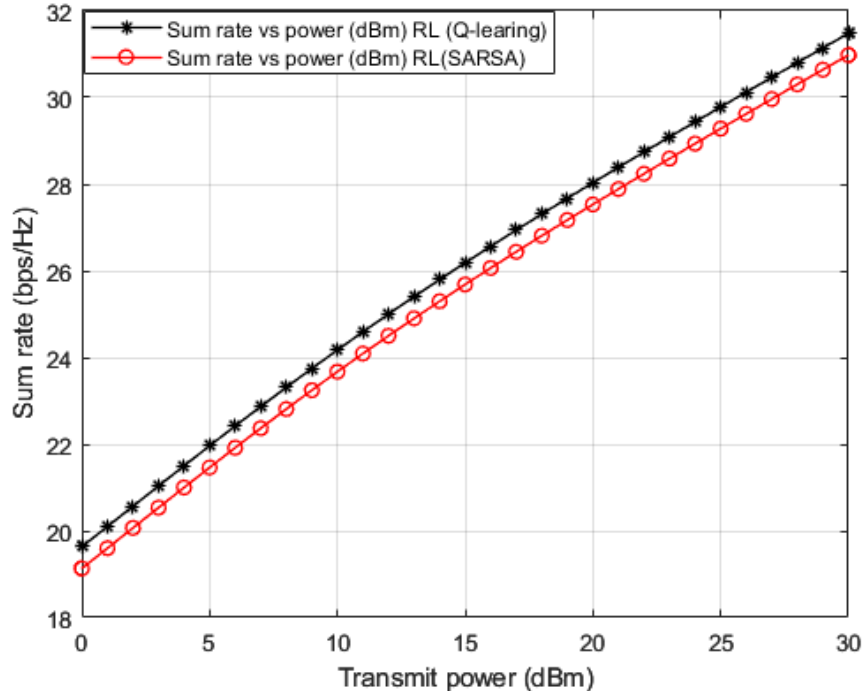
Figure 11. Sum rate vs. power ( Q ‐ learning, SARSA).